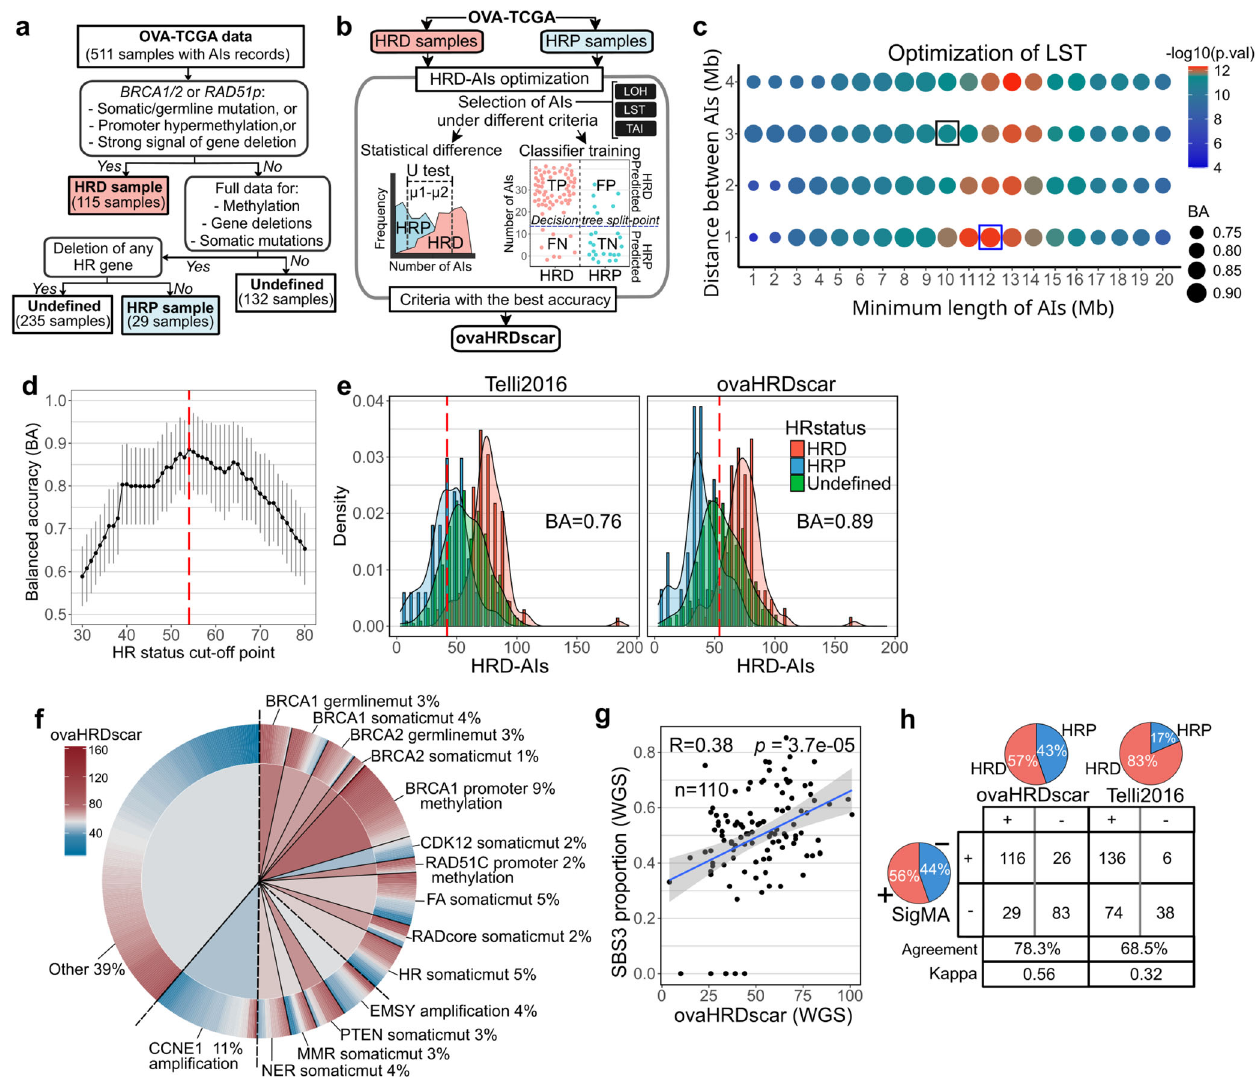
Fig. 2 Machine learning-aided detection of AIs associated with HRD shows improved accuracy and correlations with genomic features of HRD in HGSC. a Selection criteria for annotating HRD, HRP and unde fi ned HGSC samples in the OVA-TCGA. b A scheme of the approach used to generate accurate criteria for selecting HRD-AIs in HGSC samples. c For LST events, the size of dots represents the decision tree balanced accuracy (BA) of classifying HRD and HRP when selecting AIs of the corresponding criteria, the dot colors represent the statistical difference ( U test, p -value) in abundance of AIs between HRD and HRP samples. The black box corresponds to the selection criteria proposed by Telli2016, the blue box correspond to the best BA and U test value. d Evaluation of ovaHRDscar cut-off to de fi ne HR-status. The black dots connected with a line correspond to the balanced accuracy (BA) of the classi fi cation of the annotated HRD and HRP samples using the given cut-off value, the 95% con fi dence intervals are shown in gray vertical lines, value of 54 (red dashed line) corresponds to the highest BA. e Density distribution of HRD-AIs according to Telli2016 and ovaHRDscar algorithms. The red dashed line represents the cut-off established to de fi ne the HR-status using Telli2016 ( ≥ 42) and using ovaHRDscar ( ≥ 54). The BA of classi fi cation of the annotated HRD and HRP is shown, density distribution colors correspond to the samples annotated as in the panel a. f Levels of ovaHRDscar in OVA-TCGA samples harboring different genetic or epigenetic alterations associated with HRD in HGSC 4 . The colors correspond to the ovaHRDscar; in the outer ring of the pie chart every line represents a sample and in the center of the pie chart the colors correspond to the average number of HRD-AIs per genetic or epigenetic alteration. For the somatic mutations (somaticmut) gene deletions were included. g Linear regression of the proportion of single base substitution signature 3 (SBS3) and the ovaHRDscar levels in PCAWG samples (Pearson r ’ = 0.38). Blue line shows the regression line and the 95% con fi dence intervals are shown in gray. h The SBS3 status inferred using SigMA 16 showing a higher agreement with ovaHRDscar (agreement = 78.3%, Cohen ’ s kappa = 0.56) than with the Telli2016 algorithm (agreement = 68.5%, Cohen ’ s kappa = 0.32). In the pie charts and table + and - correspond to the number of HRD positive and HRD negative samples identi fi ed under each criterion, respectively. On the bottom is shown the number of samples and the level of agreement between the corresponding detected in WGS positively correlated with the proportion of SBS3 in WGS (Pearson, r ’ = 0.38, p = 3.7e − 05; Fig. 2g). The SBS3 proportions also correlated with the number of HRD-AIs using the Telli2016 algorithm in the PCAWG cohort (Supplementary Fig. 2j). We next compared the performance of ovaHRDscar to that single base substitution signature 3 (SBS3), which has been of SBS3 inferred from whole exome sequencing (WES) data with a associated with HRD 17 . We found that the ovaHRDscar levels